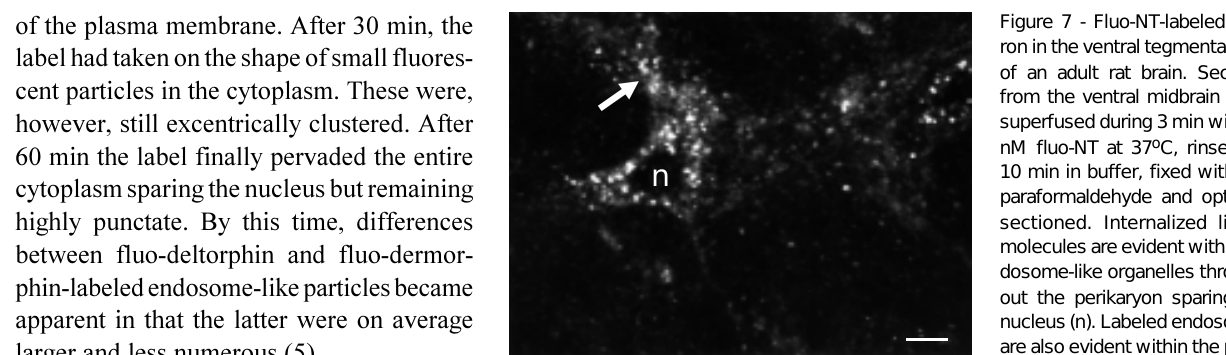
Figure 7 - Fluo-NT-labeled neu- ron in the ventral tegmental area of an adult rat brain. Sections from the ventral midbrain were superfused during 3 min with 20 nM fluo-NT at 37 o C, rinsed for 10 min in buffer, fixed with 4% paraformaldehyde and optically sectioned. Internalized ligand molecules are evident within en- dosome-like organelles through- out the perikaryon sparing the nucleus (n). Labeled endosomes are also evident within the proxi- mal processes of the cell (arrow). No labeling was apparent when the incubation was carried out at 4 o C or at 37 o C in the presence of an excess of nonfluorescent NT. Scale bar: 15